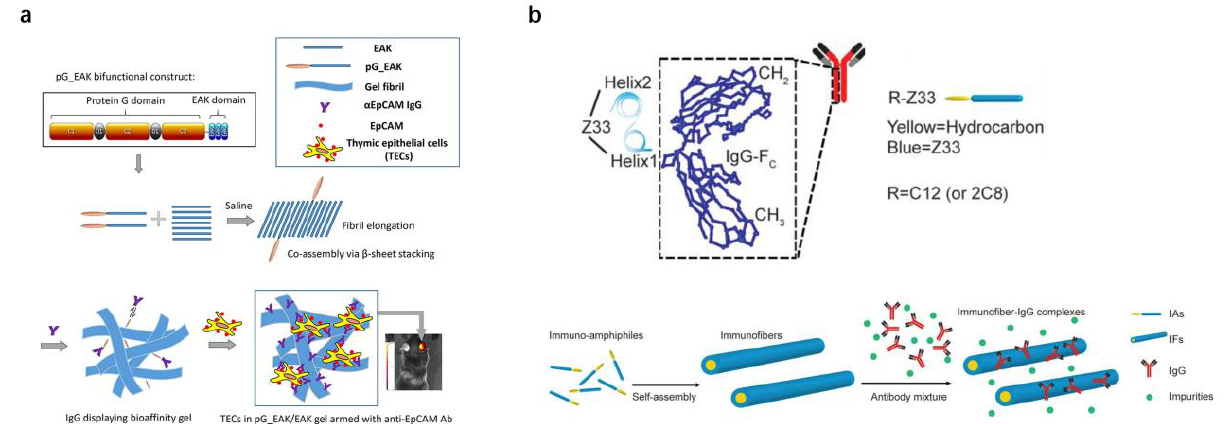
Figure 2. Examples for local delivery of antibodies based on affinity motif. ( a ) Schematic illustration of the design of pG_EAK and the co-assembly of peptide and its bioengineering applications. Reproduced with permission from Ref [46]. Copyright 2019 Acta Biomaterialia . ( b ) Schematic illustration of the Z33 peptide binding to Fc-portion of human IgG1 and the self-assembly of Immuno-amphiphiles and the binding between immunofibers and IgG. Reproduced with permission from Ref [47]. Copyright 2018 Biomaterials .